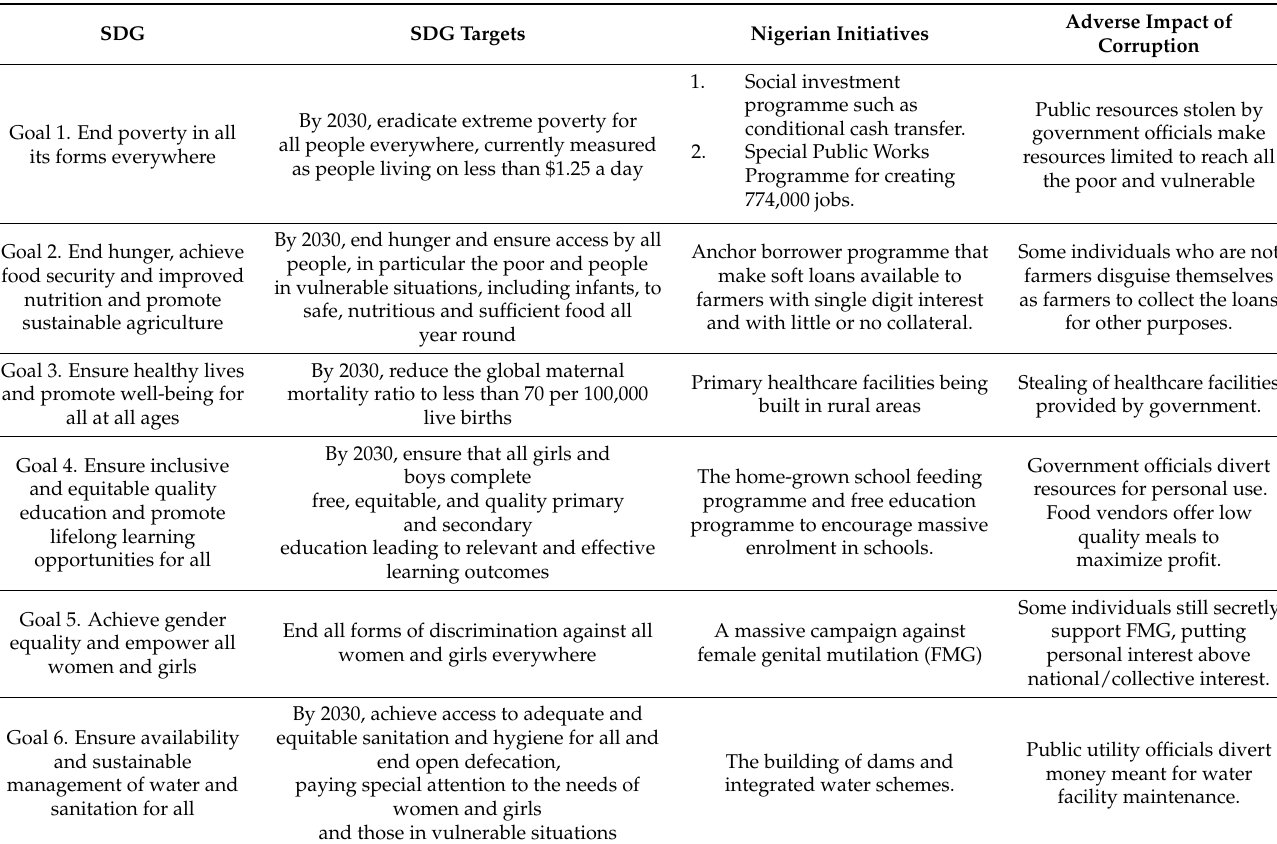
Table 1. Qualitative assessment of SDG implementation in